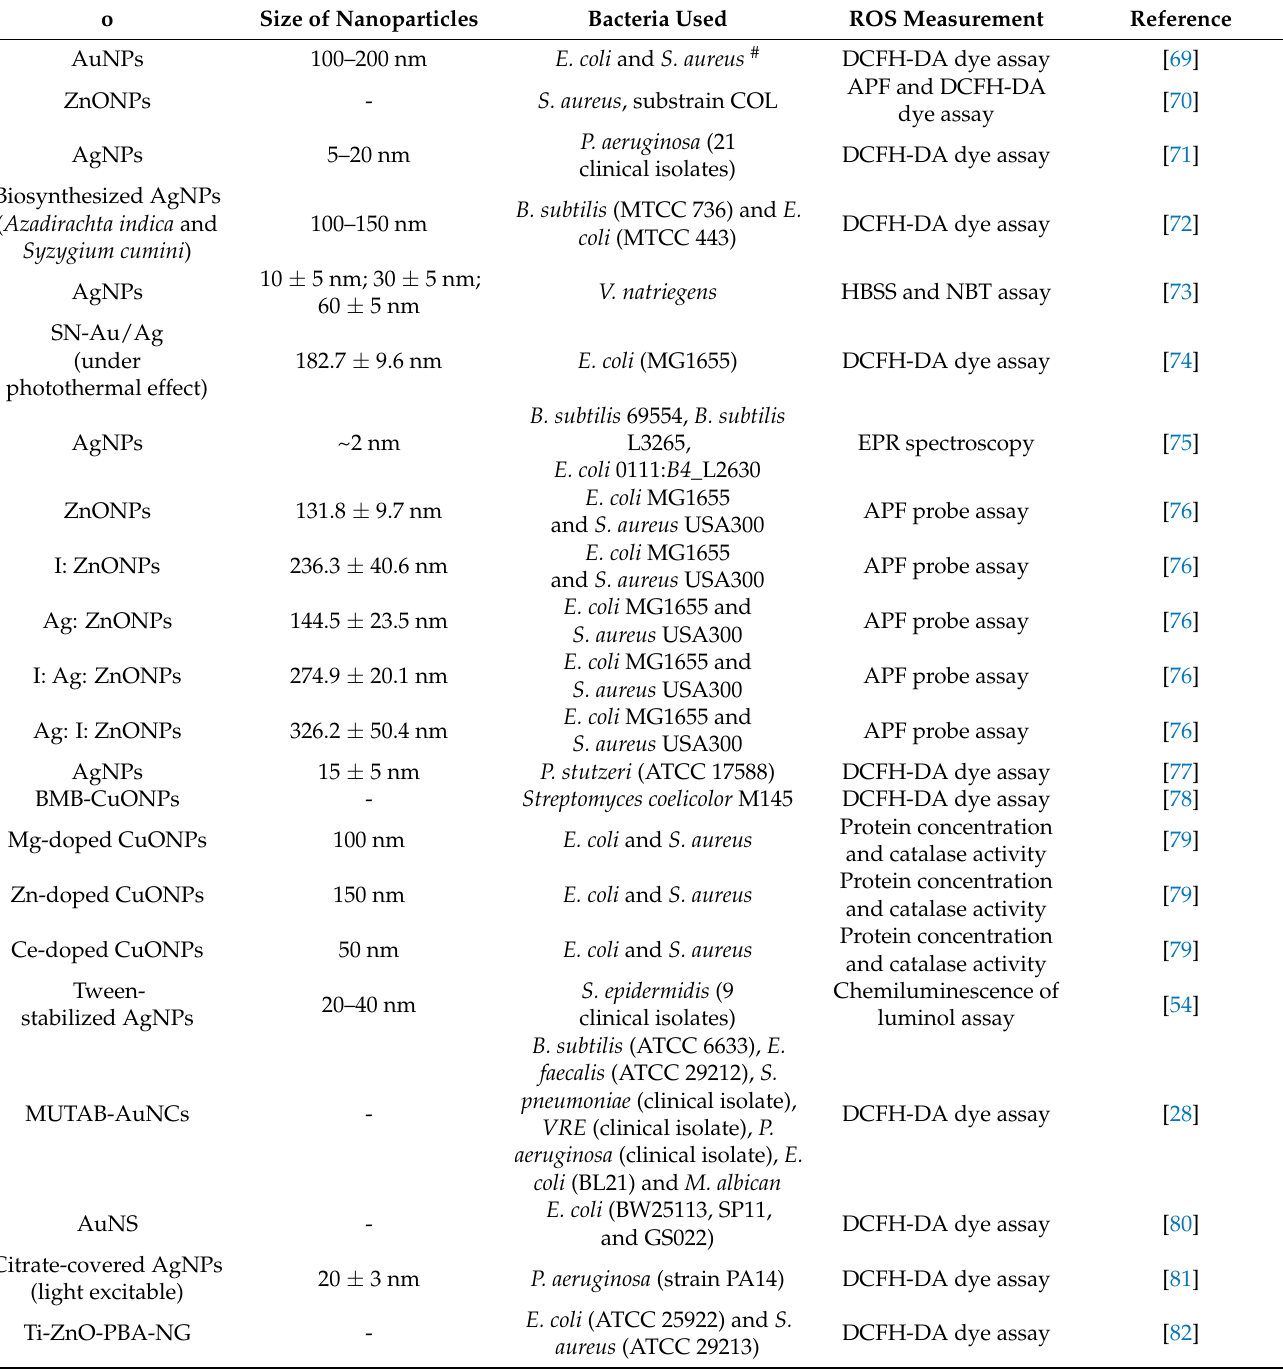
Table 1. Summary of metal-based nanoparticles inducing ROS production in